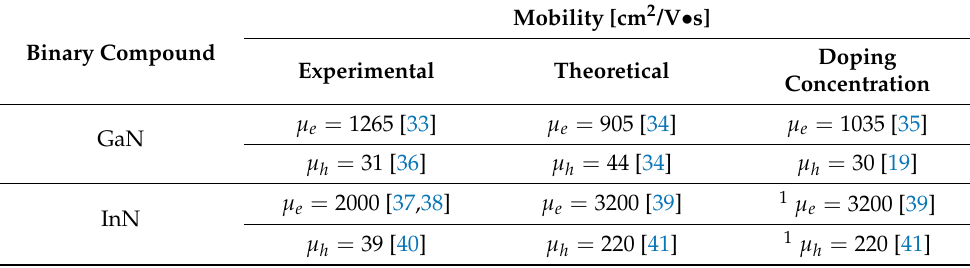
Table 1. Mobility values for binary precursor compounds of the InGaN/GaN blue LED.